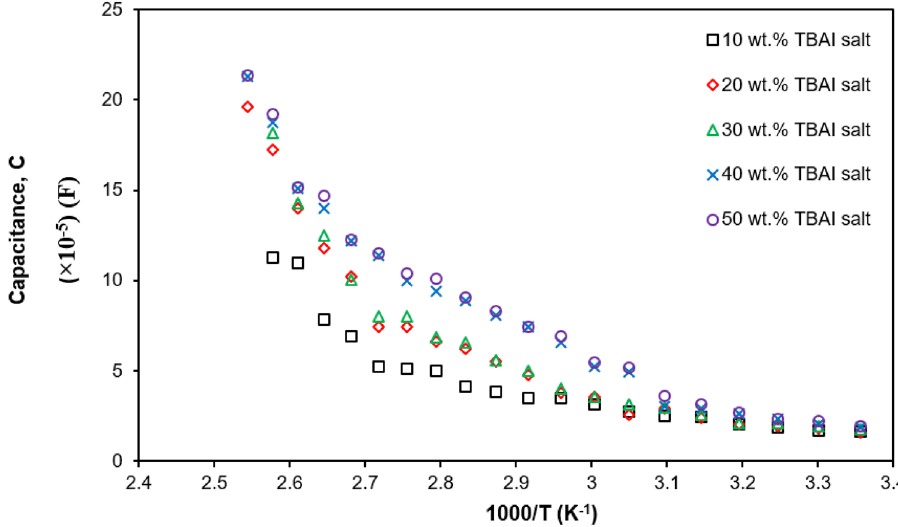
Figure 11. Temperature dependence of capacitance at different temperatures.